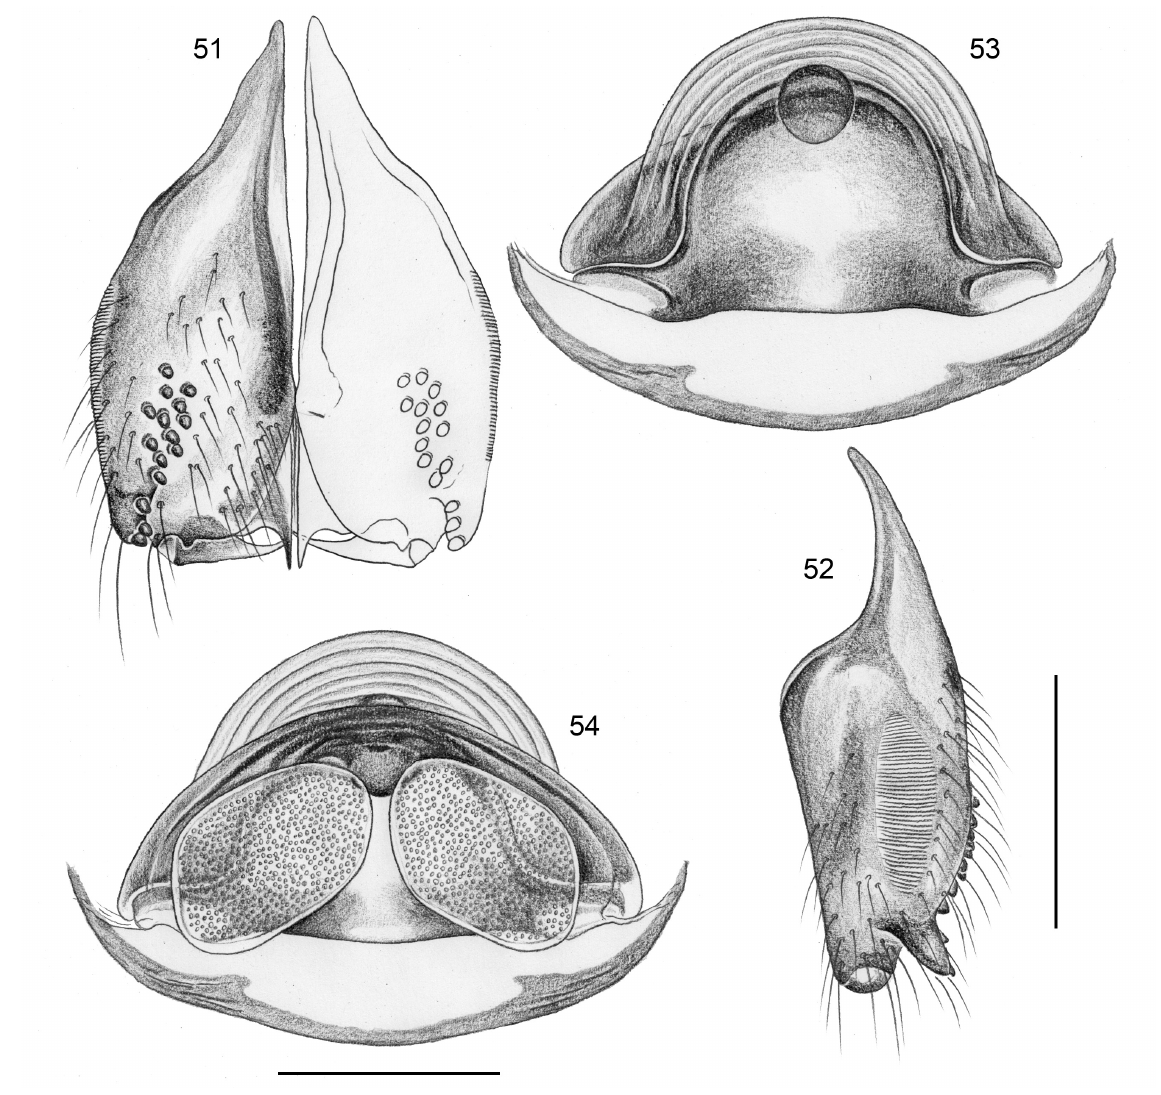
Figs 51–54. Stygopholcus skotophilus Kratochvíl, 1940; male from Ilijina pećina, Bosnia and Herzegovina (ZFMK (Ar 22198)), female from Pećina u Ivici, Montenegro (ZFMK (Ar 22196)). 51– 52 . Male chelicerae, frontal and lateral views. 53–54 . Cleared female genitalia, ventral and dorsal views. Scale bars: 0.5